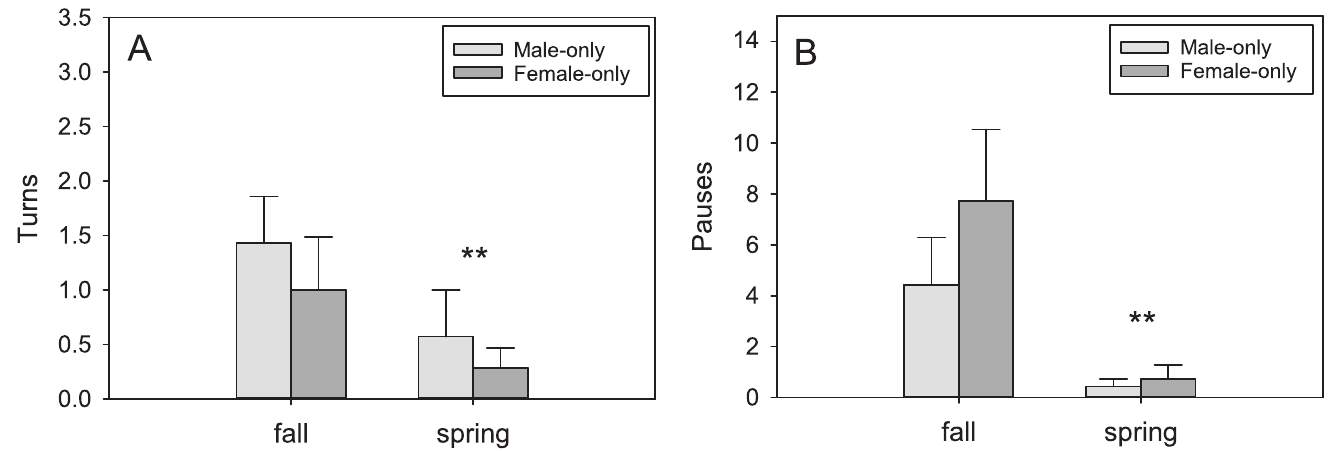
Fig 8. Seasonal differences in male tegu behaviors. Turning (A) and pausing (B) both decreased in frequency in the spring during the breeding season in the full-phase trials. Bars represent means (+SEM). �� P < 0.01.